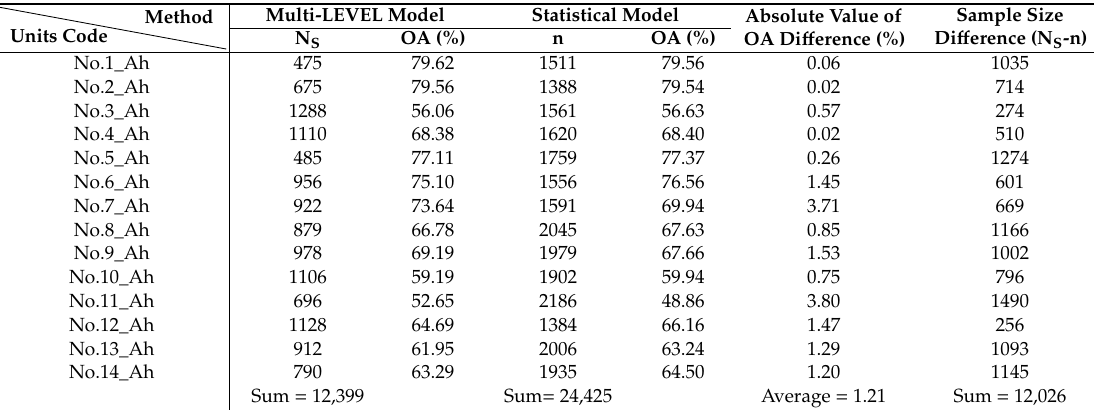
Figure 9. The divided watershed units in the Anhui Province. Table 7. Comparison of sample size and accuracy calculated from statistical model and this study (No. = Number).